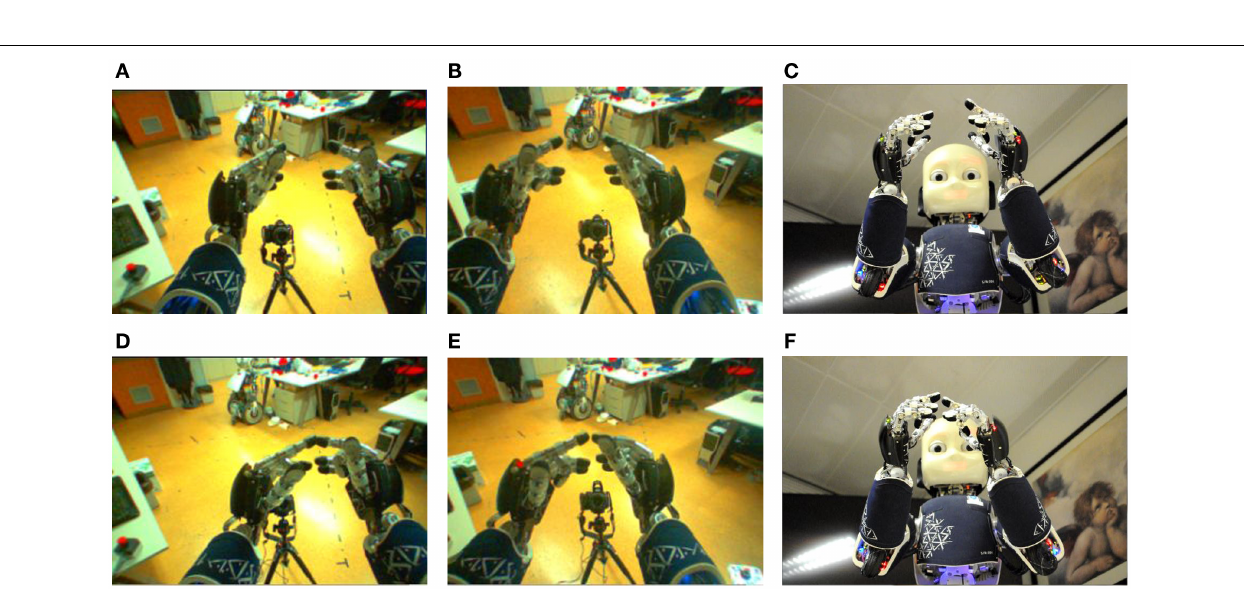
Frontiers in Robotics and AI |